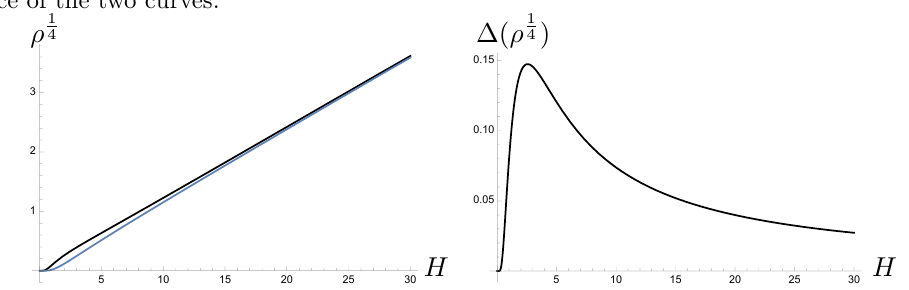
Figure 3 . One the left: the dependence ρ ( m ) at fixed value of the temperature H = 2 . The black curve is the expression (2.58), whereas the blue curve the flat space result (2.62). On the right: the difference of the two curves.